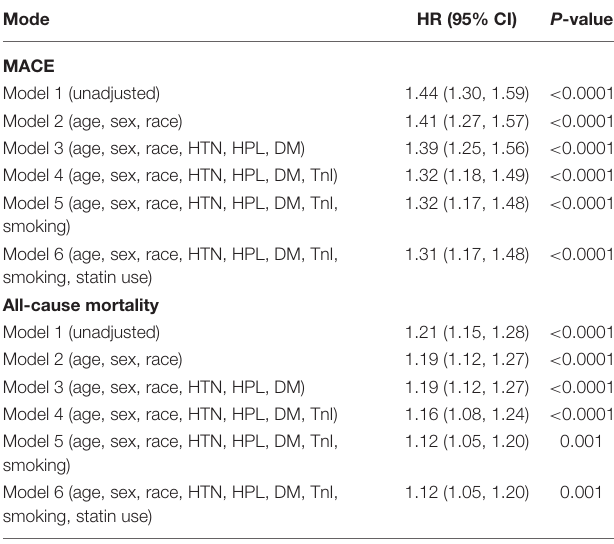
TABLE 2 | Multivariable Cox regression analysis for adverse outcomes according to CAC total